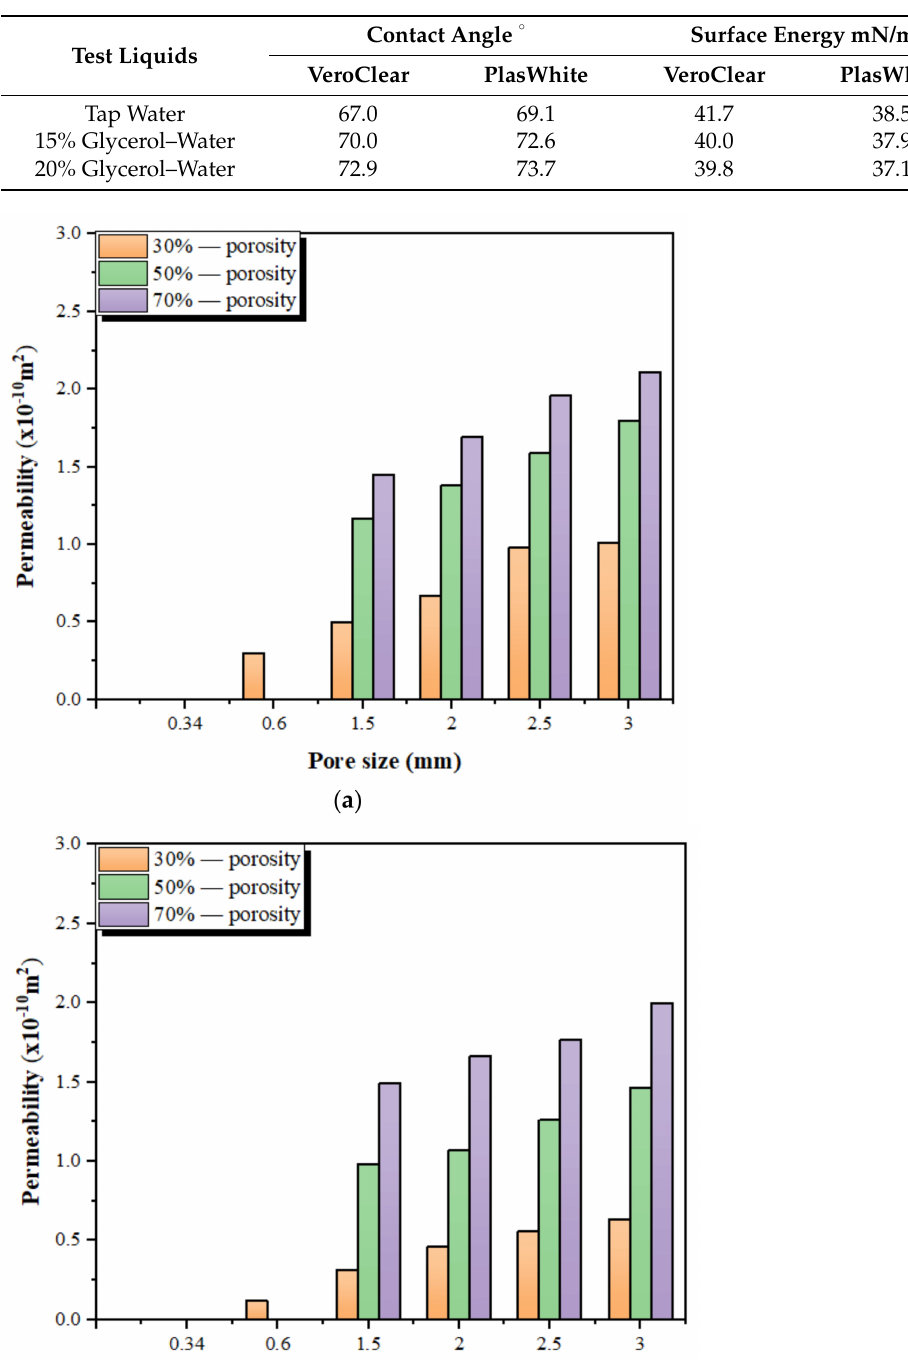
Table 3. Contact angle and surface energy values for PolyJet (VeroClear) and µ SLA (PlasWhite) 3D-printed scaffold structures.